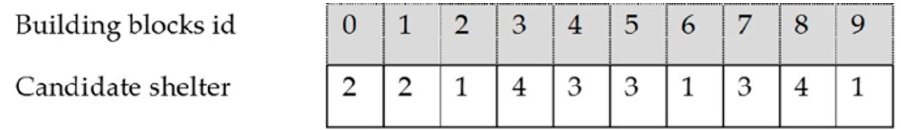
Figure 3. An example of an initialized bee represents assigned shelter on each building block.